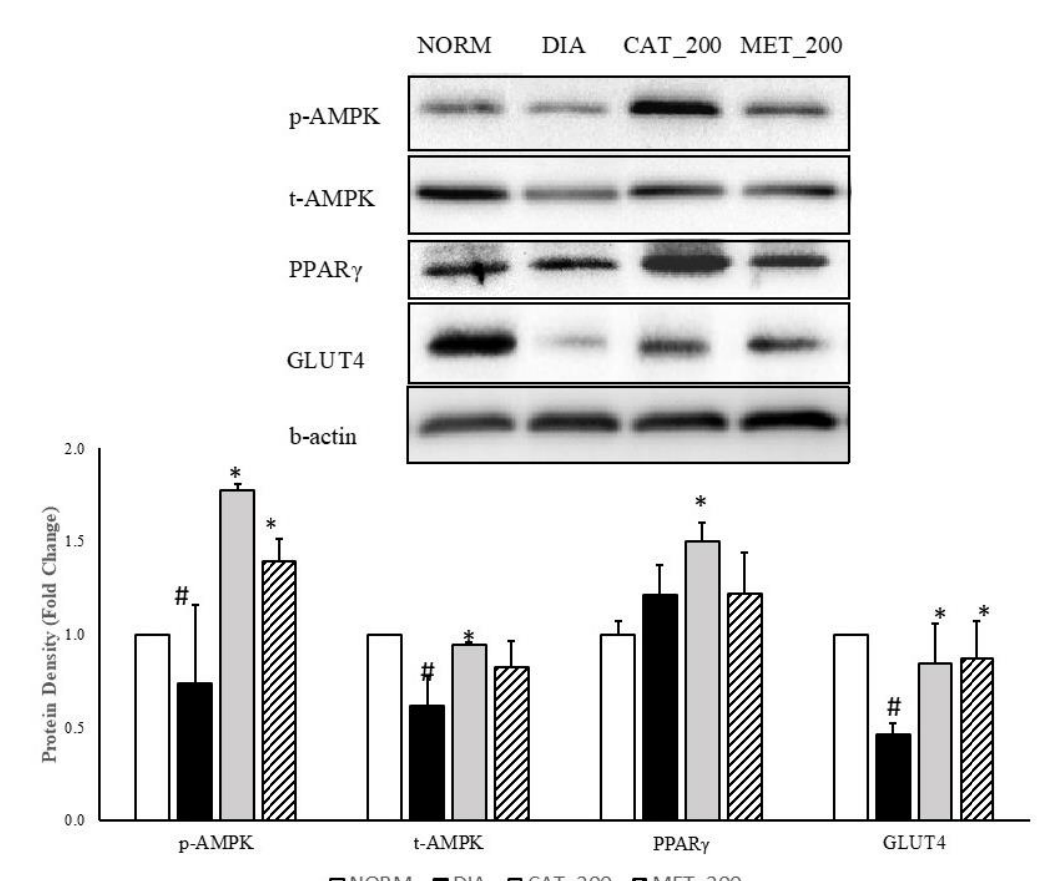
Figure 4. Effect of catalpol and metformin on proteins (AMPK, PPAR-γ and GLUT4) in skeletal muscle (gastrocnemius and soleus muscle). NORM: Normal control; DIA: Diabetic control; CAT_200: Catalpol (200 mg/kg; p.o.); MET_200: Metformin (200 mg/kg, p.o.). Data represents mean ± SEM ( n = 6–8). # p < 0.05 vs. NORM and * p < 0.05 vs. DIA.